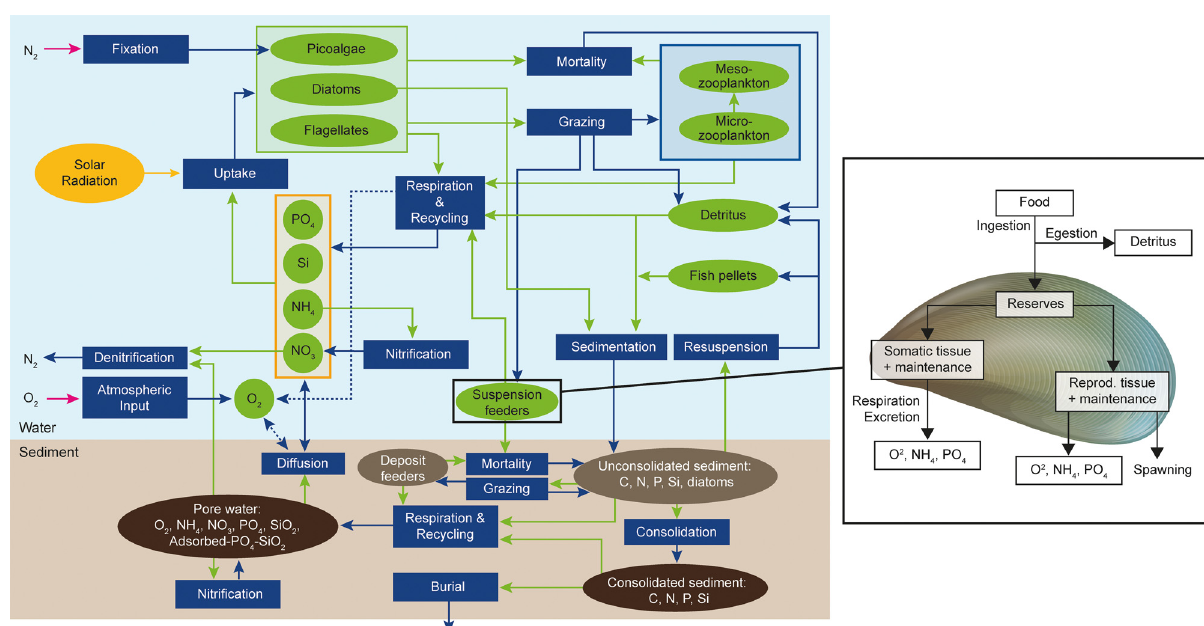
Fig. 3. Pelagic (green) and benthic (brown) state variables and associated fluxes (blue) in the biogeochemical ERGOM model. Sus- pension feeders are described in more detail as blue mussels using a dynamic energy budget model combined with a population model for the long-line mussel farms at 0−6 m depth. Modified from Maar et al.